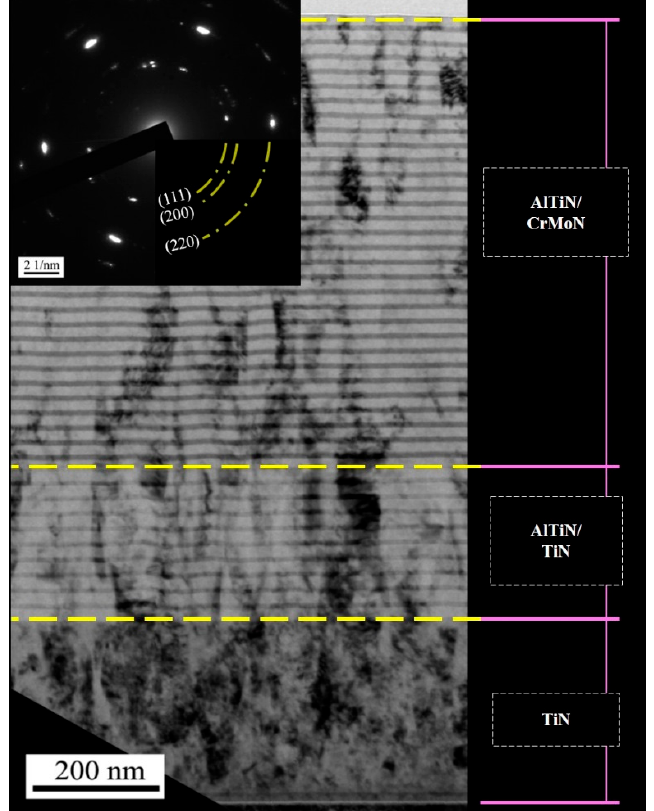
Figure 3. Cross-sectional transmission electron microscope (TEM) micrographs of the deposited AlTiCrMoN-2 coating and corresponding selected-area electron diffraction (SAED) pattern of the top multilayered AlTiN/CrMoN.